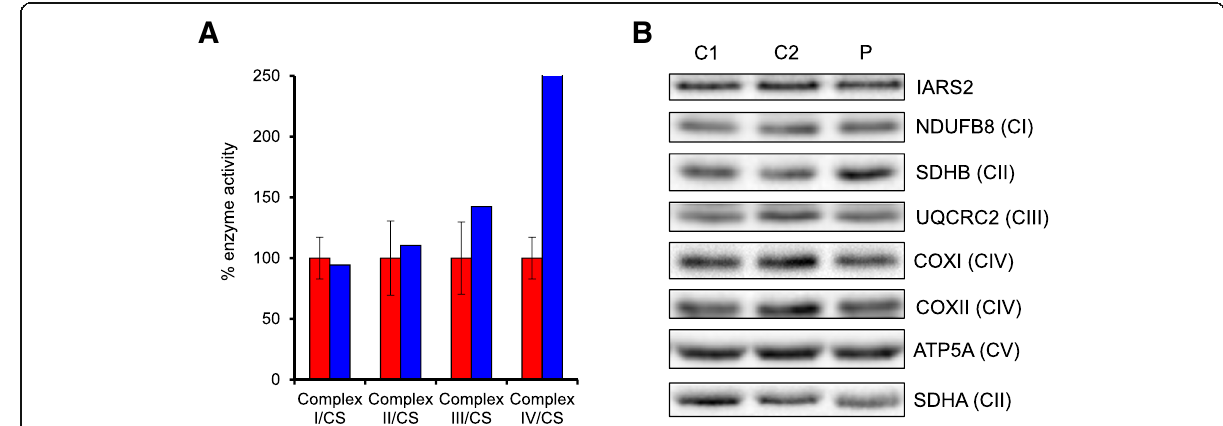
Fig. 4 Biochemical and western blot analyses of patient fibroblasts. a Activity of mitochondrial respiratory complexes in control (red) and patient (blue) fibroblast samples. Mean enzyme activities normalised to citrate synthase (CS) of control fibroblasts ( n = 8) are set to 100% and error bars represent standard deviation. b Western blots of protein lysate from patient fibroblasts (P) and two age-matched controls (C1 and C2) immunodecorated with antibodies against IARS2, NDUFB8 (CI), UQCRC2 (CIII), COXI (CIV), COXII (CIV) and ATP5A (CV). SDHA and SDHB (CII) were used as loading